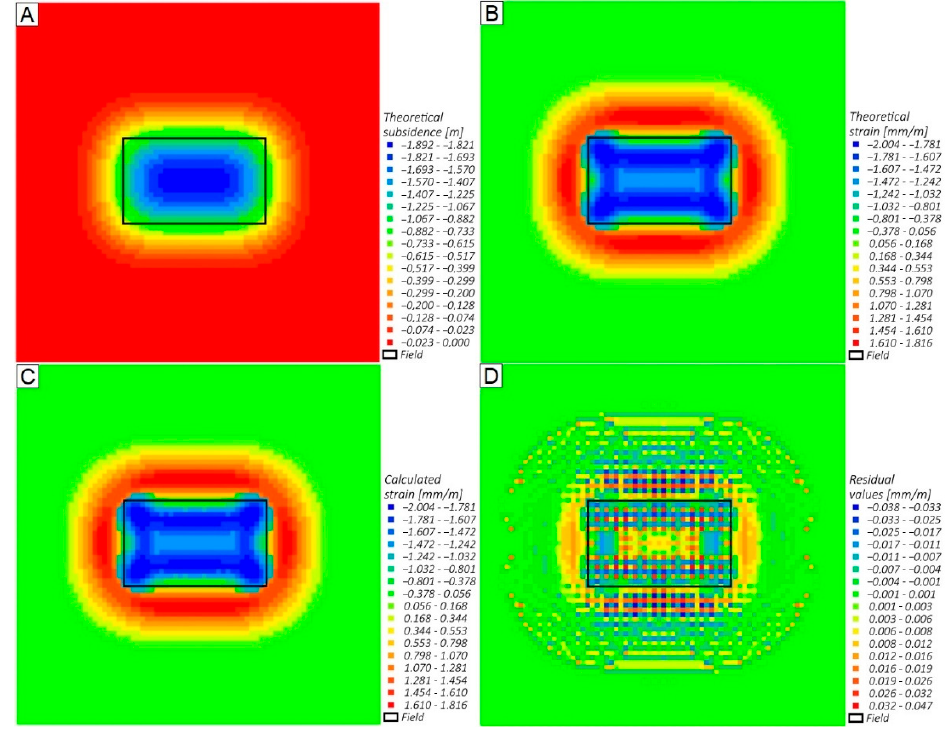
Figure 5. The vertical displacements ( A ) and the horizontal strains ( B ) obtained from model data. The calculated deformation values ( C ) follow the same colour scheme as the model values. The disparity between theoretical and calculated values is displayed in ( D ).